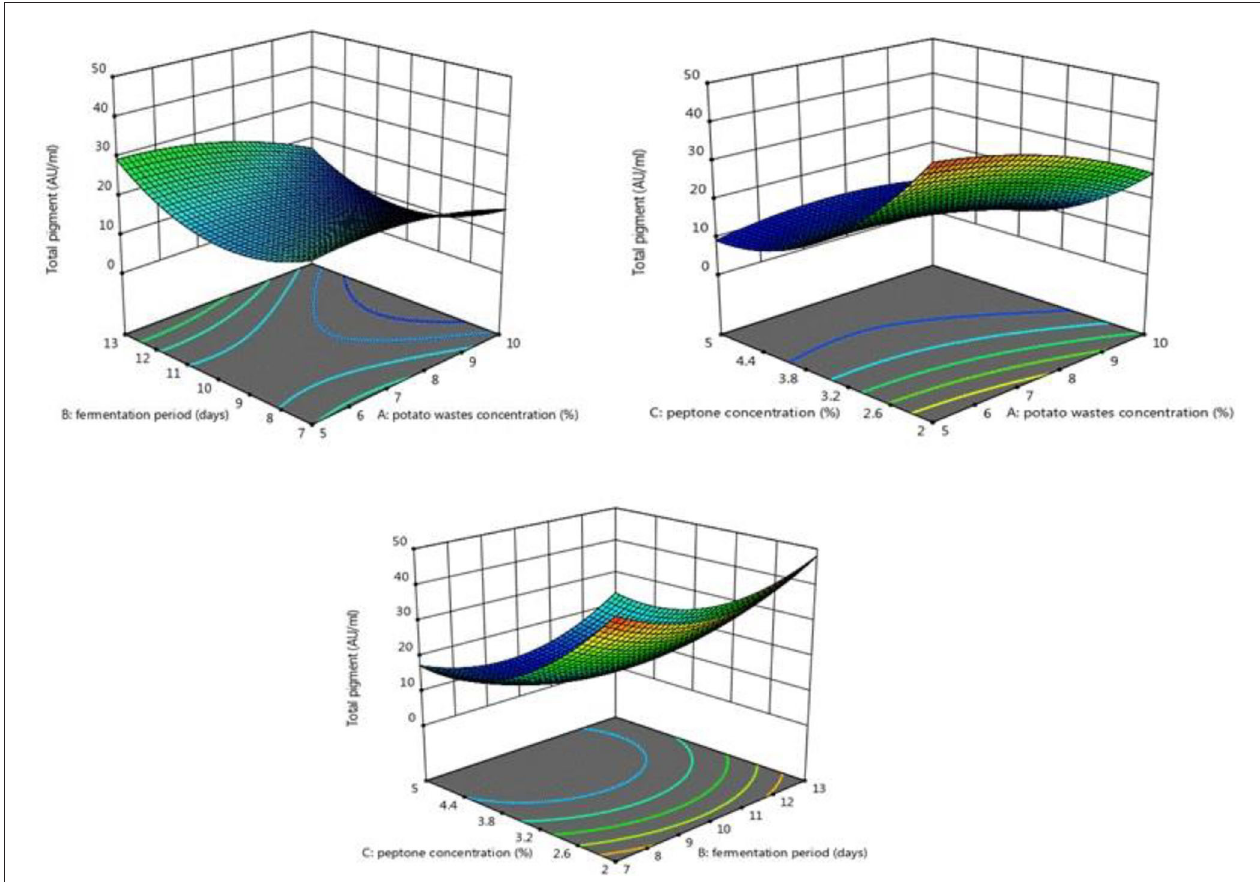
FIGURE 5 | Response surface plots indicated the effect of potato wastes concentration, peptone concentration, and fermentation period on total pigment production.